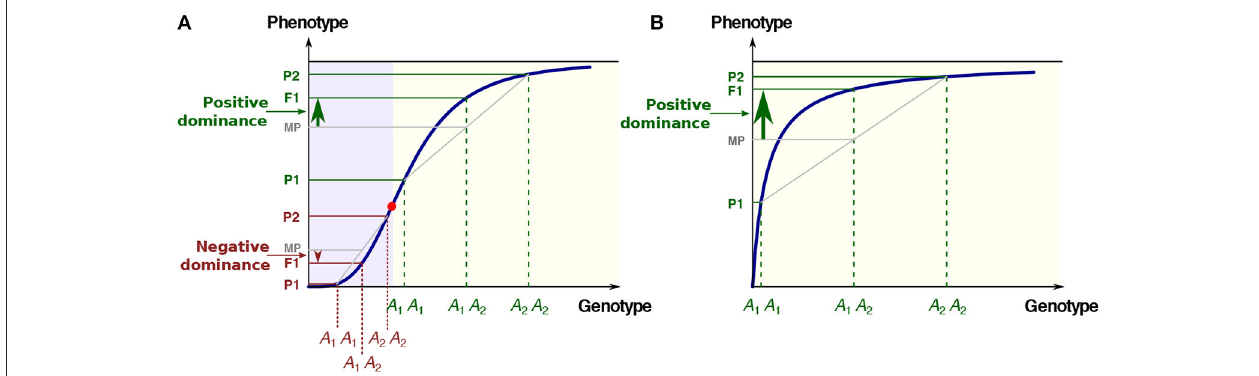
FIGURE 1 | The two most common types of GP relationships with possible inheritance. (A) The S-shaped relationship. There is convexity below the abscissa of the inflection point (red point) and concavity above. The three phenotypes P1, F1, and P2 are associated with the three genotypes A 1 A 1 , A 1 A 2 , and A 2 A 2 , respectively. MP: mid-parental value. In the convex region of the curve (mauve background), the low allele is dominant over the high allele (negative dominance), while in the concave region of the curve (yellow background) the high allele is dominant over the low allele (positive dominance). (B) The hyperbolic concave relationship. Whatever the genotypic values, there is positive dominance. In all cases there is additive inheritance of the genotypic